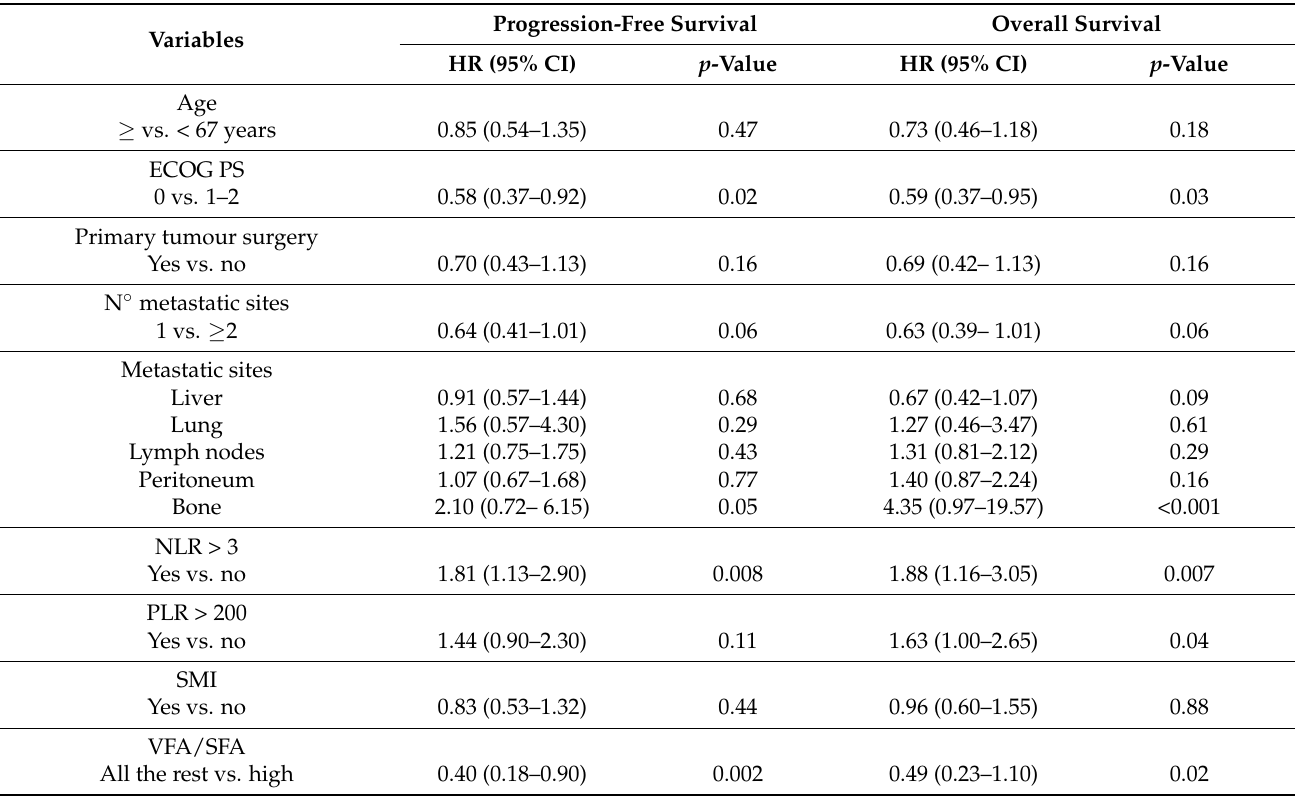
Table 2. Univariate analyses for progression-free survival and overall